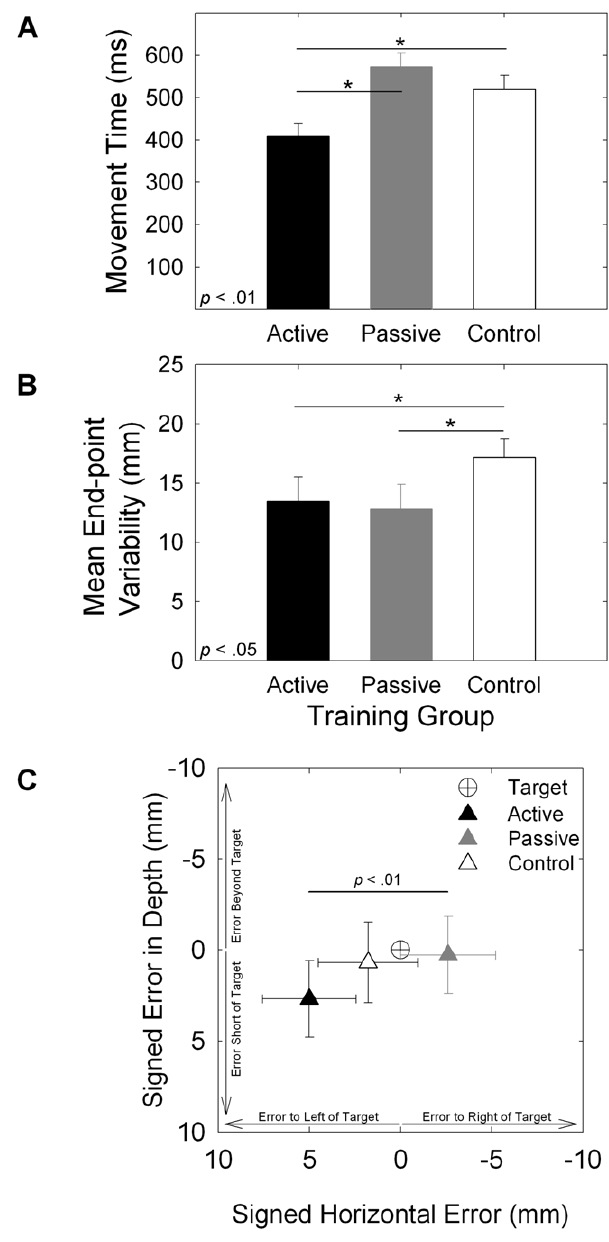
Figure 3. Motor learning results for the test phase. Panel A: Movement time (ms) as a function of training group, Panel B: mean end-point variability (mm) as a function of training group, Panel C: mean signed error (mm) as a function of training group. Error bars represent 95% confidence intervals.